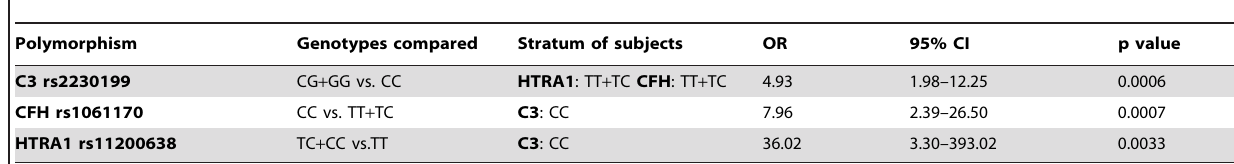
Stratum represents genotype of subjects involved in the analysis.